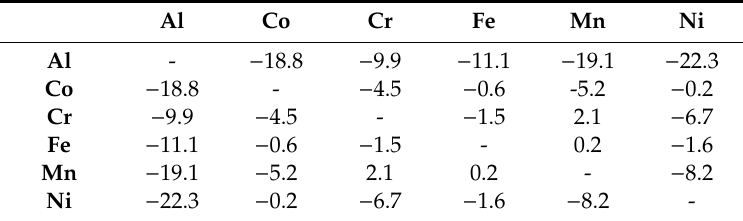
Table 2. Selected values of interaction parameters calculated by Miedema’s scheme within the framework of the sub-regular solution model [55]. Only the zero-order coe ffi cients Ω 0 are presented. Al Co Cr Fe Mn Ni Al - − 18.8 − 9.9 − 11.1 − 19.1 − 22.3 Co − 18.8 - − 4.5 − 0.6 -5.2 − 0.2 Cr − 9.9 − 4.5 - − 1.5 2.1 − 6.7 Fe − 11.1 − 0.6 − 1.5 - 0.2 − 1.6 Mn − 19.1 − 5.2 2.1 0.2 - − 8.2 Ni − 22.3 − 0.2 − 6.7 − 1.6 − 8.2 -